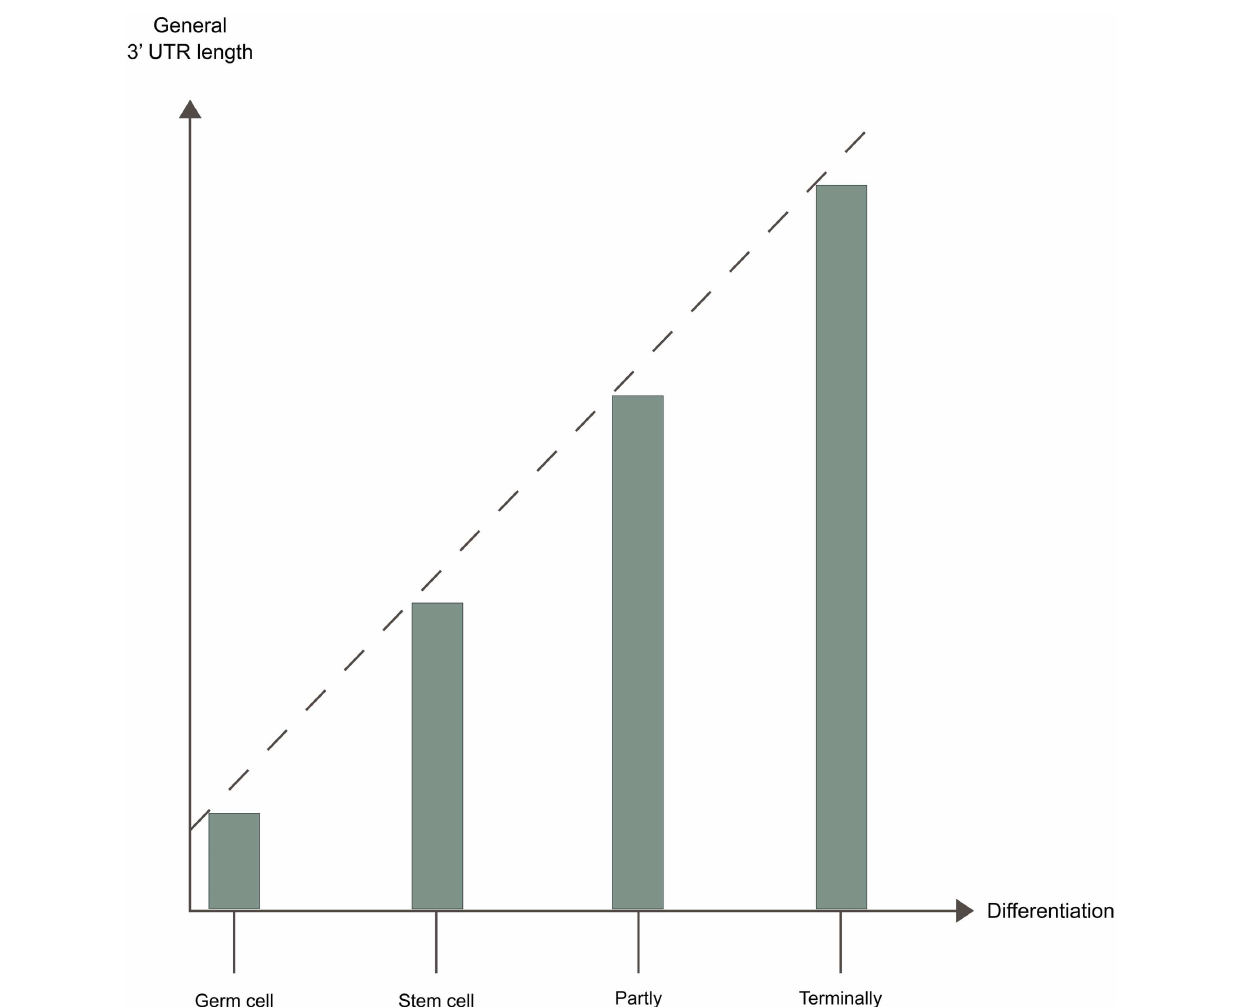
poly(A) sites with less responsive proximal poly(A) sites in